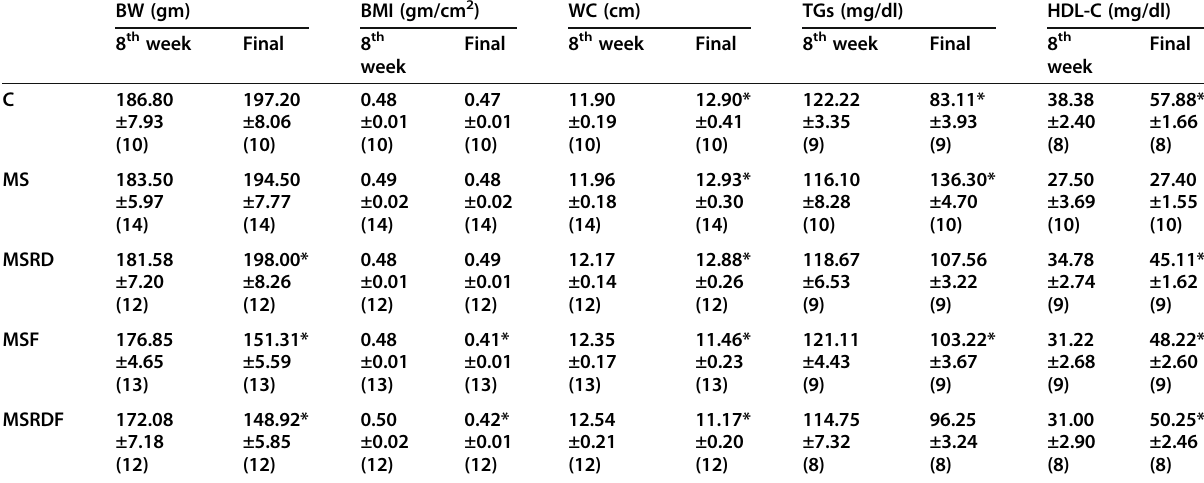
C, control group, MS, untreated metabolic syndrome group, MSRD, metabolic syndrome group reverted to regular rat chow, MSF, metabolic syndrome group on alternate day fasting, MSRDF, metabolic syndrome group reverted to regular rat chow and on alternate day fasting; BW, body weight; BMI, body mass index; WC, waist circumference; TGs, triglycerides; HDL-C, high density lipoprotein cholesterol In the parenthesis is the number of observations Data are expressed as mean ± SEM *: Significance from 8 th week value, by Student's “ t ” test for paired data, at P ≤